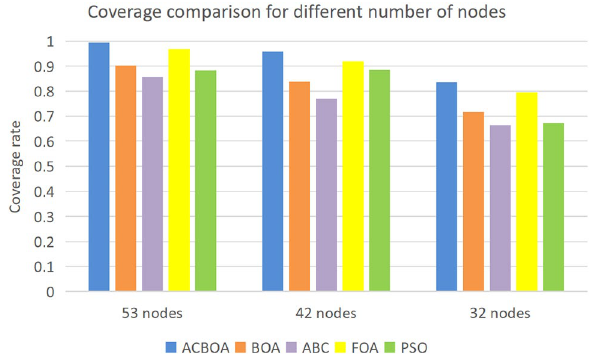
Figure 7. Coverage comparison.